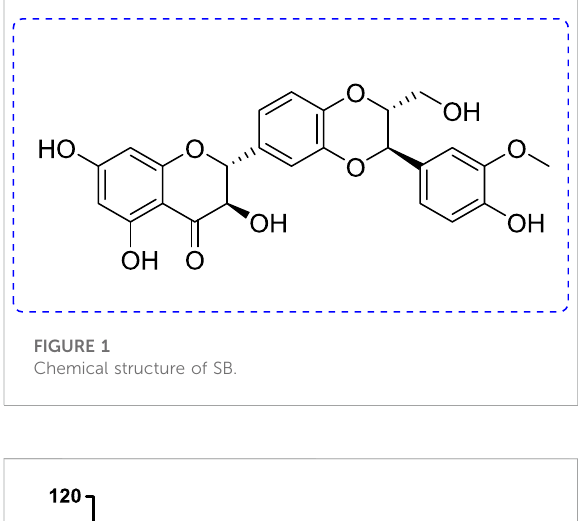
FIGURE 1 Chemical structure of SB.